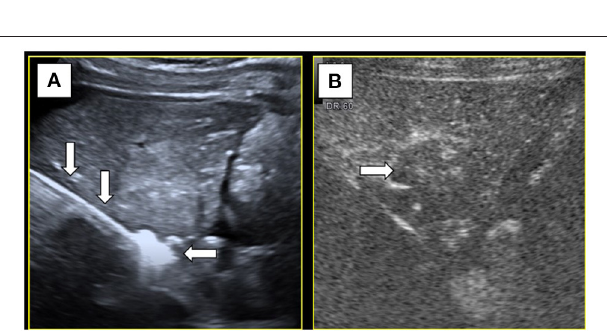
FIGURE 2 | Normal saline and SonoVue (100:1) were infused into abdominal cavity. Contrast-enhanced ultrasound (A) , along with B-mode ultrasound (B) showed that SonoVue distribution between the gallbladder( ⋆ ) and the liver ( → ), suggesting that ascites could separate the gallbladder wall away from the liver to avoid thermal injury.